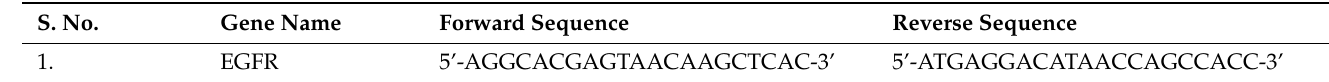
Table 1. EGFR primer sequences .